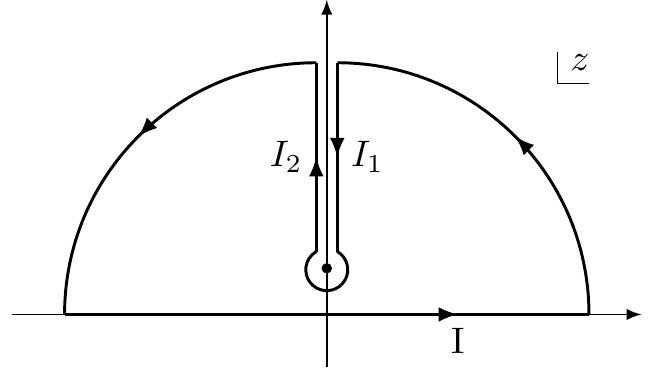
Figure 1 . Integration contour for the integral with n < 0 and p <